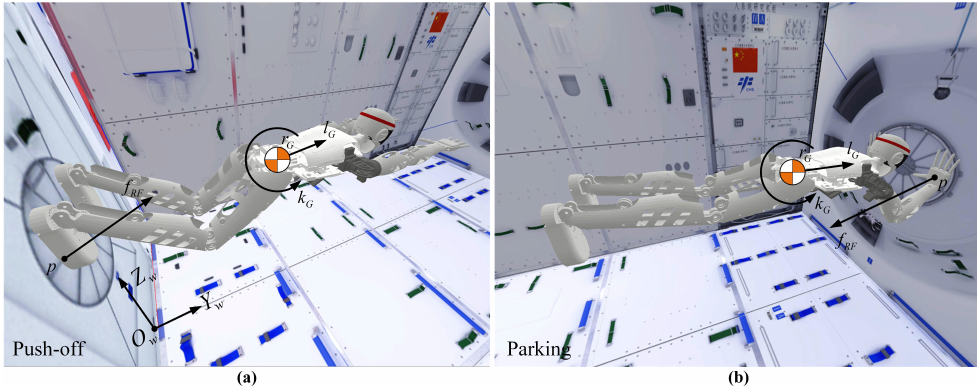
Figure 6. Reaction forces exerted on Taikobot during the multi-contact PFP locomotion in the ( a ) push-off phase and ( b ) parking